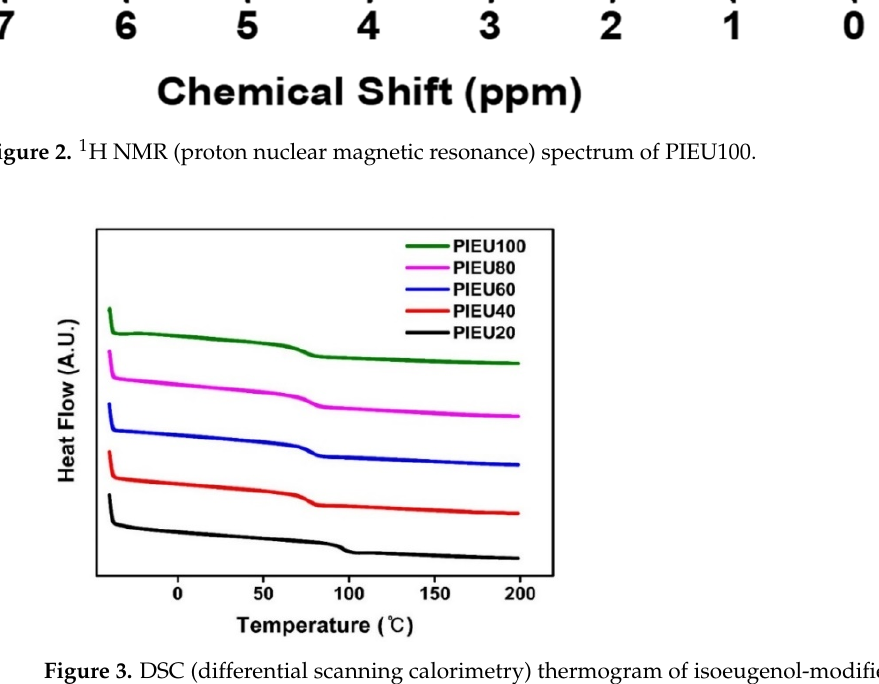
Figure 4. Conoscopic polarized optical microscopy images of the liquid crystal (LC) cells fabricated with PIEU100 films under the following weight ratios of PIEU100: ( a ) 0.001, ( b ) 0.01, ( c ) 0.05, ( d ) 0.1, and ( e ) 1.0 wt.%. Figure 5 shows photographic images of LC cells made from the PIEU# copolymers. The LC cells fabricated with PIEU# films with an isoeugenol side group content of less than 40 mol% (PIEU40) partially showed LC texture with birefringence, while good uni- formity of vertical LC alignment behavior was observed for LC cells fabricated with the polymer films with an isoeugenol side group content of at least 60 mol% (PIEU60, PIEU80, and PIEU100) in the entire area image area. All of the PIEU100 films could induce stable vertical LC aligning behaviors, and the vertical LC alignment was sustained for at least several months. Therefore, as the content of the isoeugenol side groups increased, the ver- tical aligning capability of the LC cells made from polymers increased.